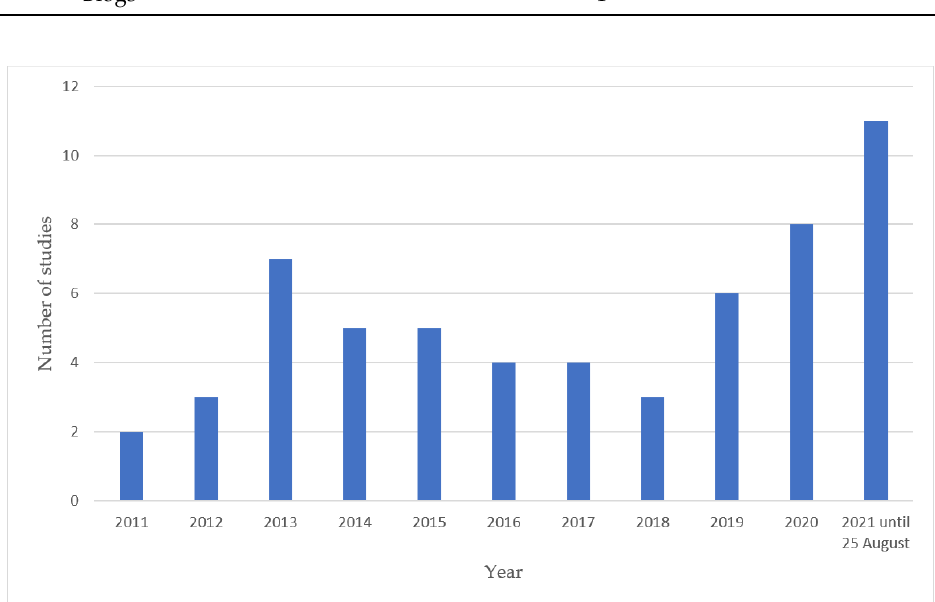
Figure 2. Number of included studies by year of publication.